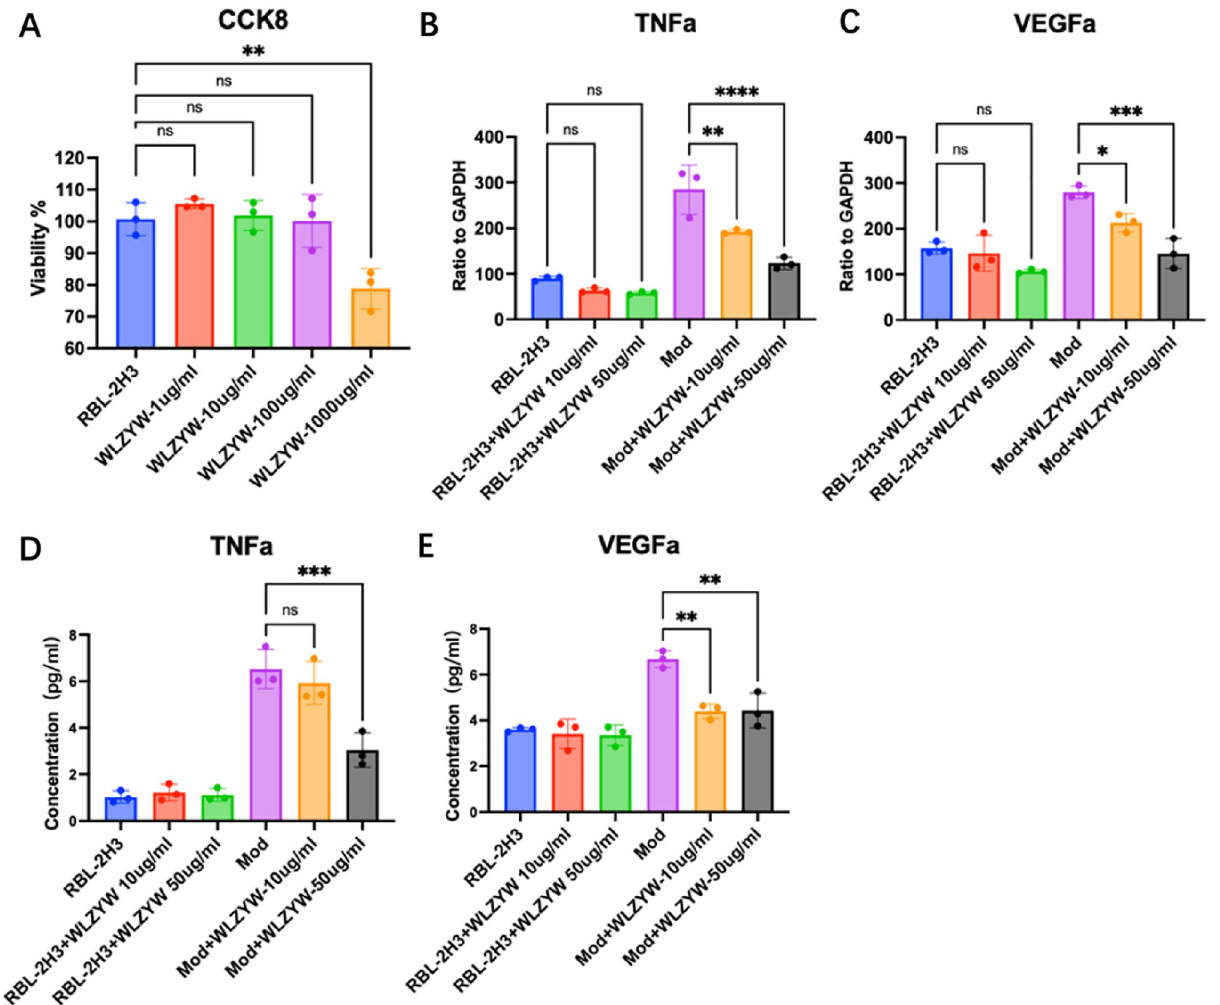
Figure 5. Effects of WLZYW on DNP-IgE/BSA-induced RBL-2H3 cells. CCK8 assay indicated that WLZYW was not cytotoxic to RBL-2H3 cells in certain range ( A ). QRT-PCR showed that WLZYW reduced mRNA expression of TNF-α ( B ) and VEGFa ( C ). Elisa showed that WLZYW decreased VEGFa protein expression ( E ), but only TNF-α protein expression decreased at high concentrations ( D ). Values represent mean ± SD from three independent experiments. *p < 0.05, **p < 0.01, ***p < 0.001, ****p < 0.0001, ns means no significant